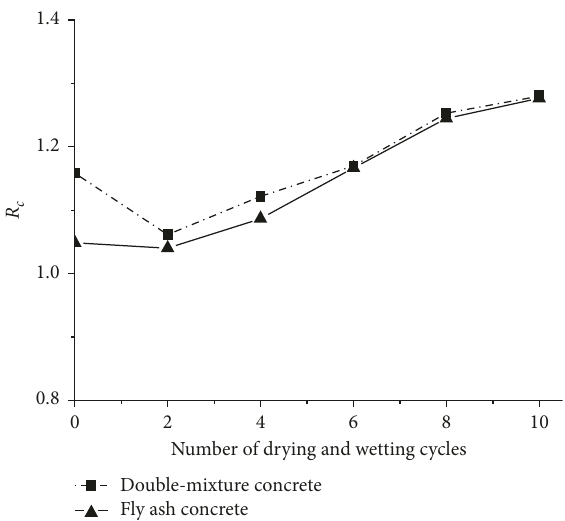
Figure 5: Relative compressive strength ratio of modified concrete corroded by Na 2 SO 4